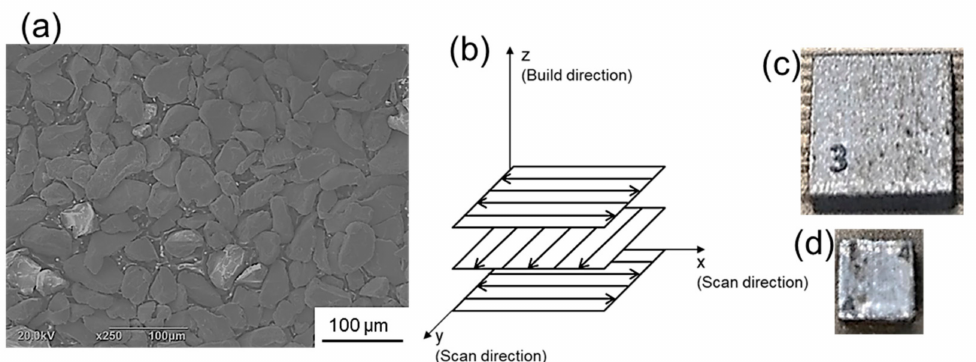
Figure 1. ( a ) Morphology of pure Cr powders used in laser powder bed fusion processing (LPBF), ( b ) schematic presentation of the laser scan strategy, and ( c , d ) appearance of as-built Cr specimens with dimensions of 10 × 10 × 5 mm and 5 × 5 × 5 mm along the x-, y-, and z-axes, respectively.